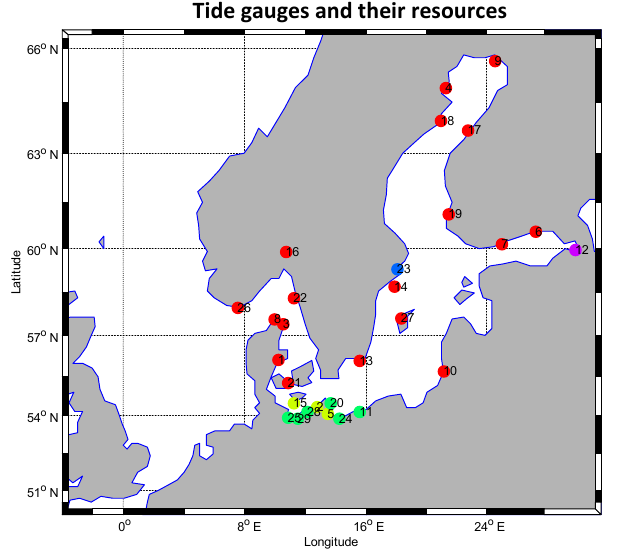
Figure 1. Tide gauges with their sources. 1: Aarhus, Barth, Frederikshavn, and Furuogrund; 5: Greifswald, Hamina, Helsinki, Hirtshals, and Kemi; 10: Klaipeda, Kolobrzeg, Kronstadt, Kung- sholmsfort, and Landsort; 15: Marienleuchte, Oslo, Pietarsaari, Ratan, and Rauma; 20: Sassnitz, Slipshavn, Smogen, Stockholm, and Swinoujscie; 25: Travemünde, Tregde, Visby, Warnemünde, and Wismar (stations are ordered alphabetically). Red: PSMSL; purple: Bogdanov et al.; yellow: TUD; green: PSMSL and TUD; blue: Ekman and